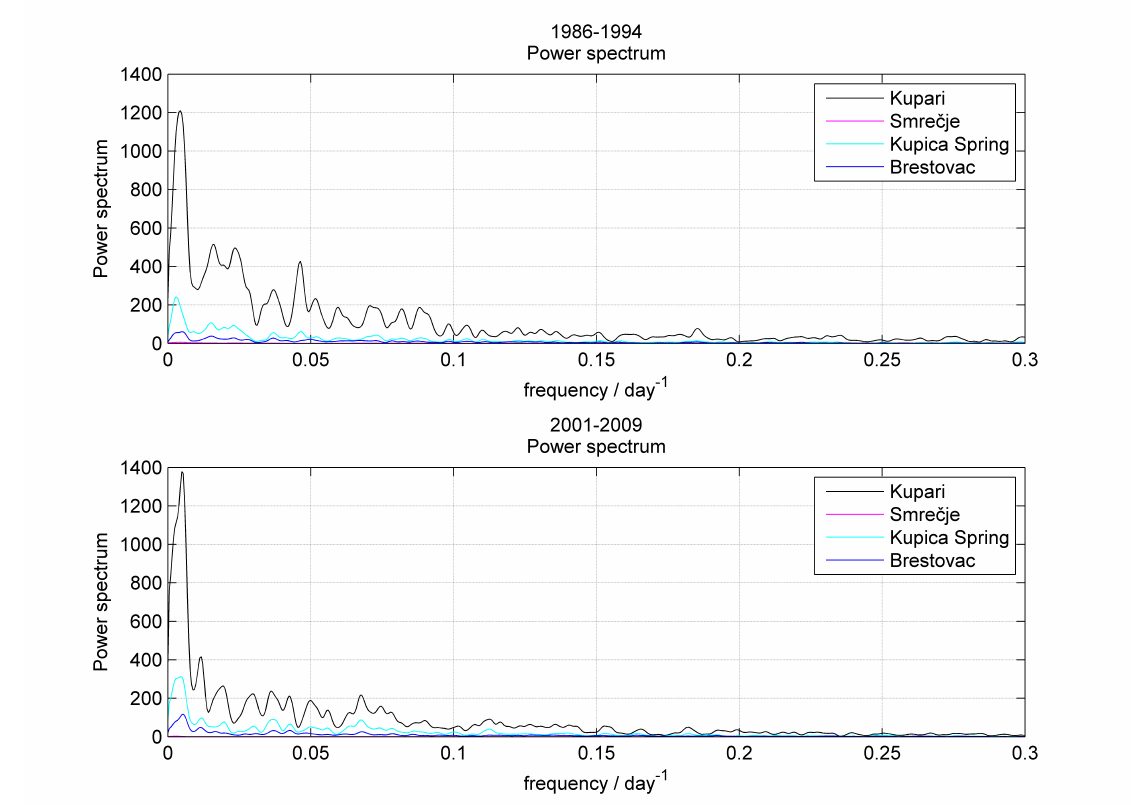
Figure 6. The power spectrum obtained for the studied hydrological stations for the two analyzed periods.